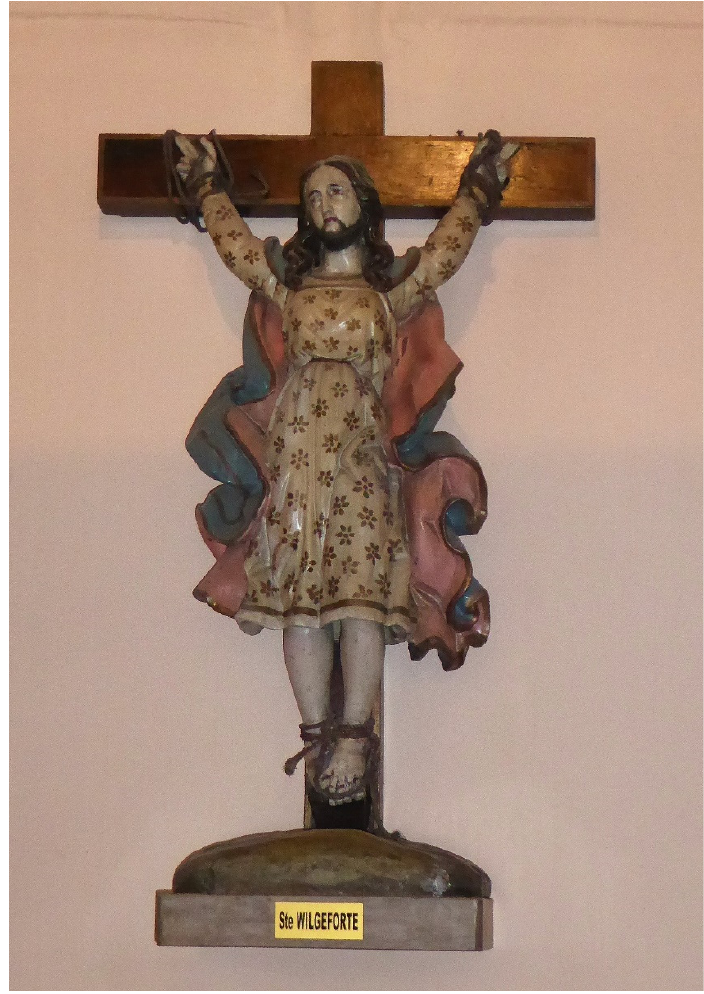
Figure 4. Statue of Ste. Wilgeforte (date unknown), St. Nicolas Church of Wissant (Pas-de-Calais, France). Photo Credit: PIERRE ANDRE LECLERCQ, own work, CC BY-SA 4.0, https://commons.wikimedia.org/w/index.php?curid=50011929 (accessed on 29 May 2022).